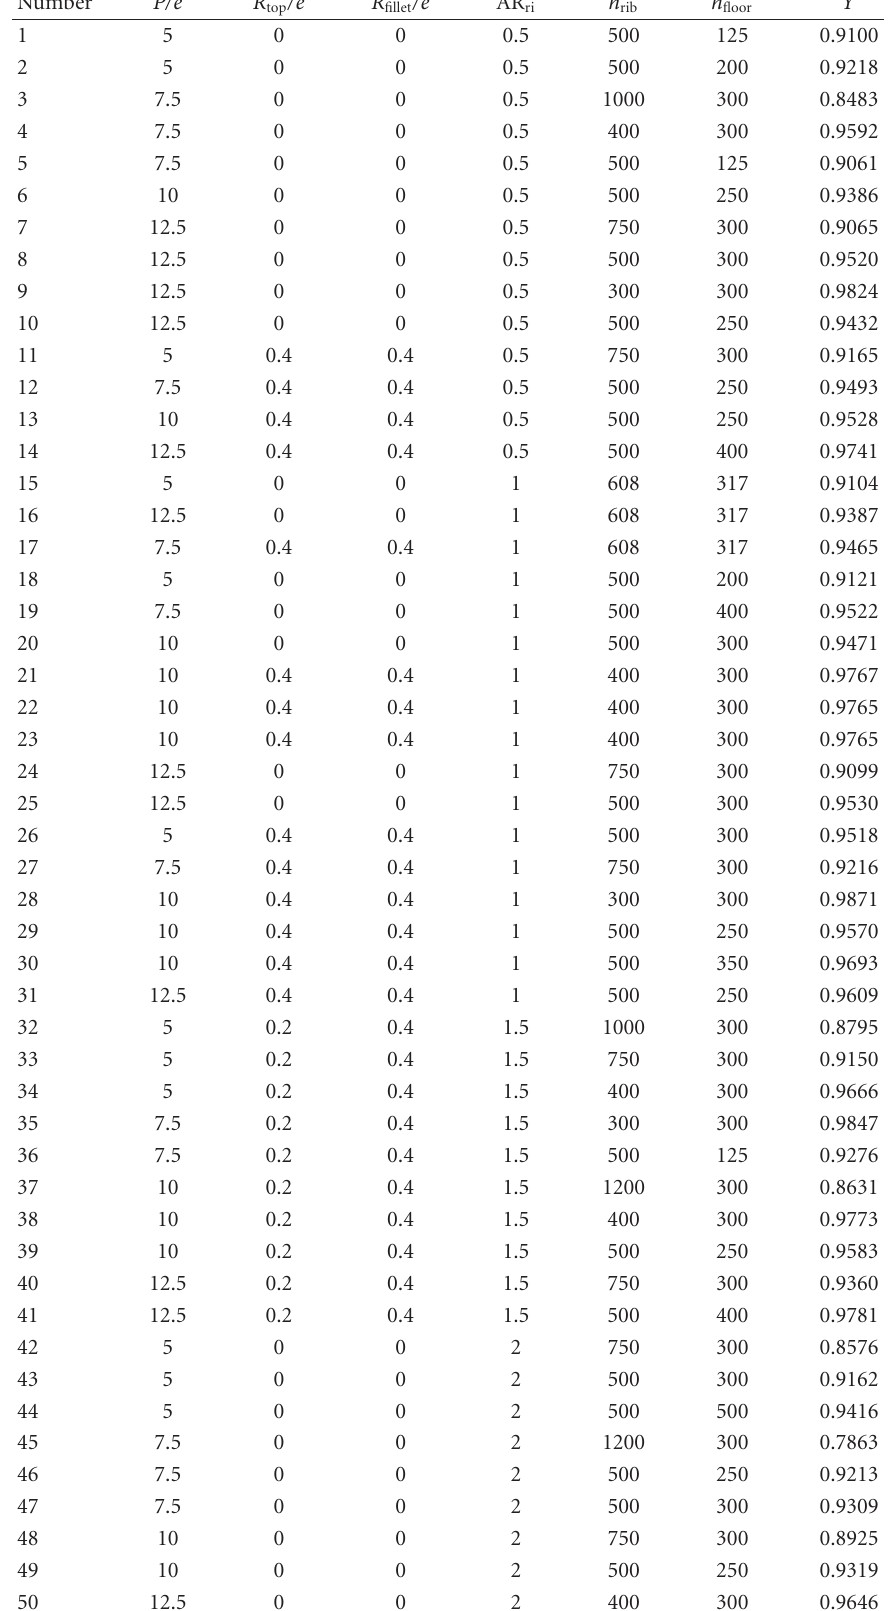
Table 2: Randomly chosen data